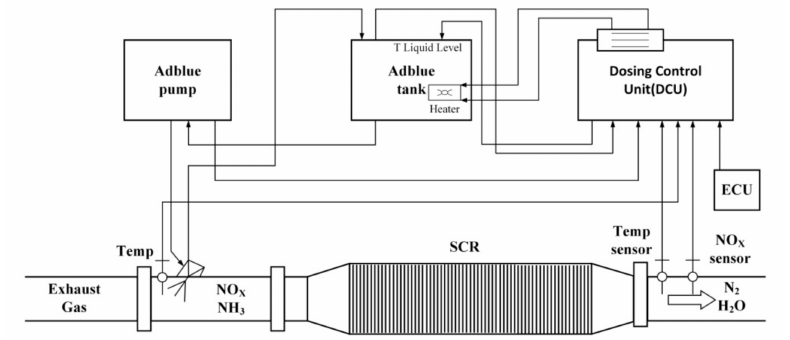
Figure 1. Schematic diagram of a selective catalytic reduction (SCR)